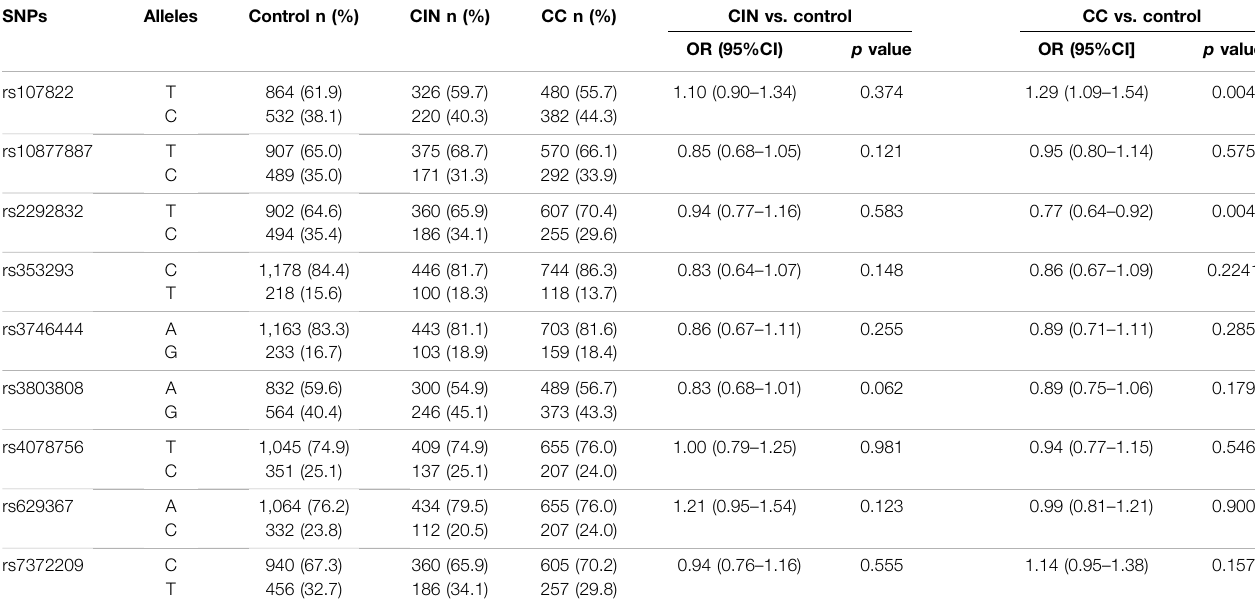
TABLE 4 | The Allele distribution of the nine SNPs in control, CIN and CC groups. SNPs